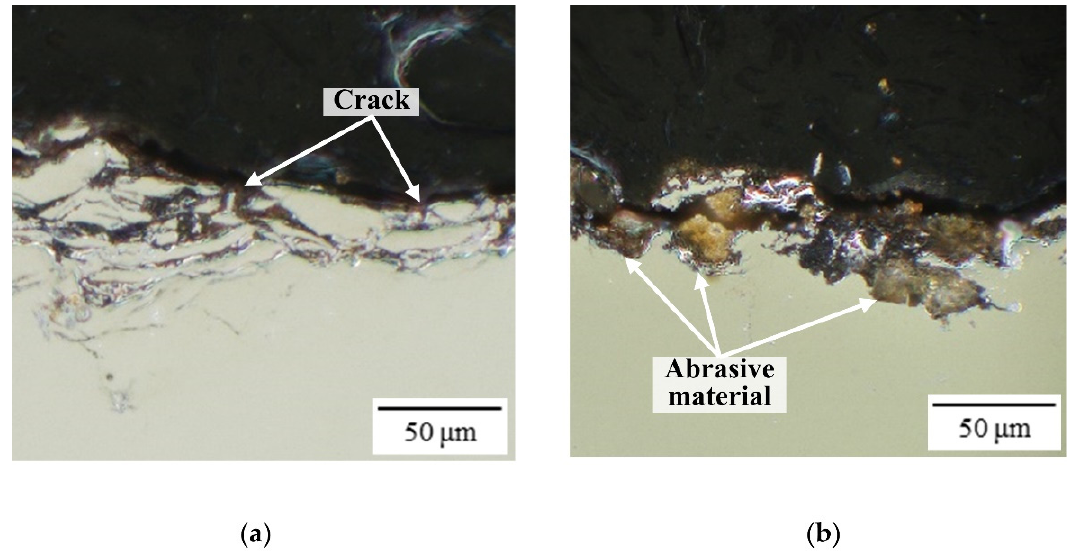
Figure 12. Microscopic images of the cross-section of the blasted specimens after immersing in 3.5 wt% NaCl solution: ( a ) MST, ( b ) MAL.